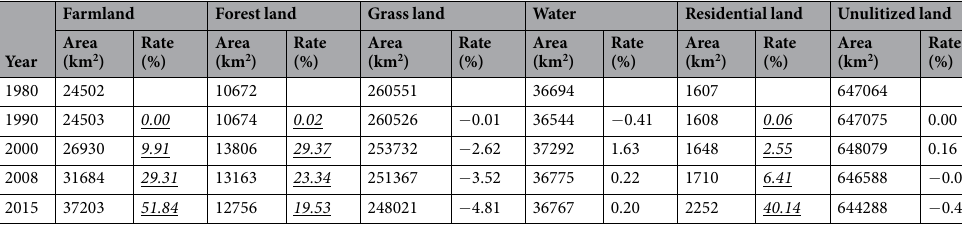
Table 5. Change of land use and vegetation cover in the Tarim River Basin in 1980, 1990, 2000, 2008, and